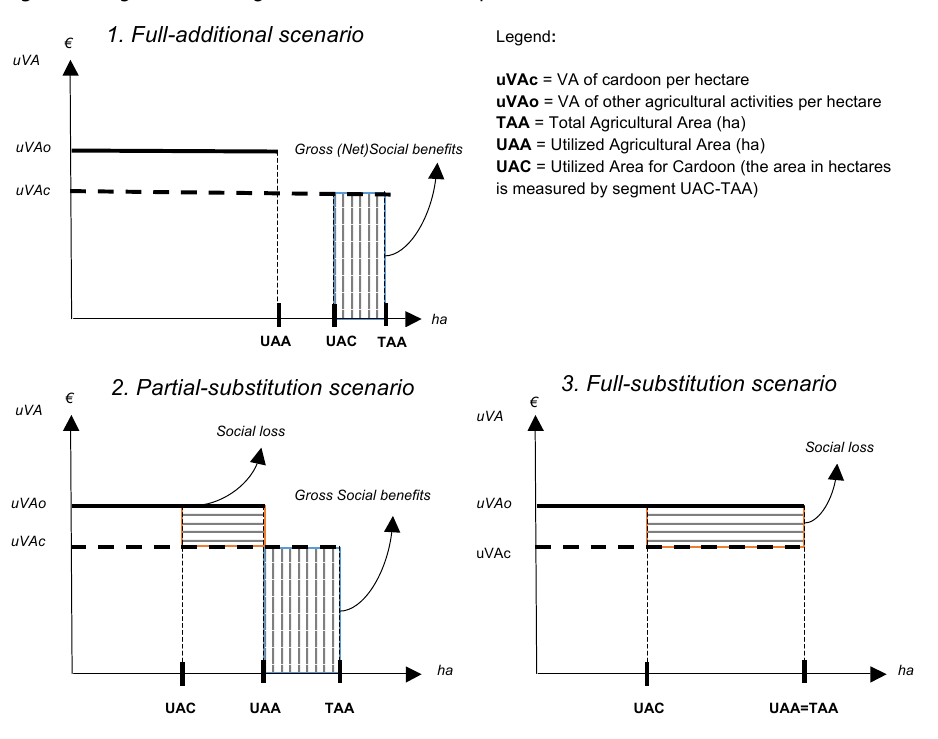
Figure 2. Diagram describing the three scenarios